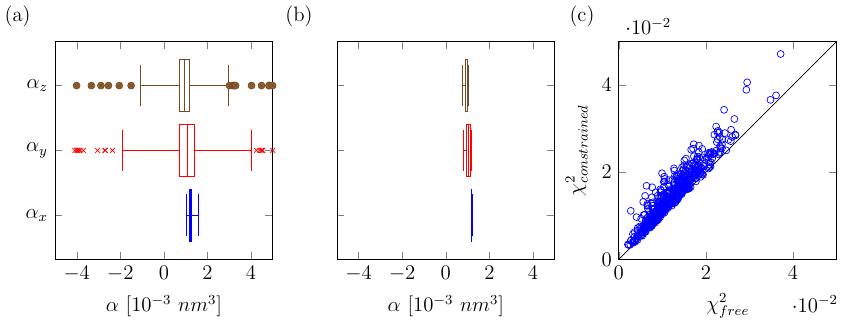
Figure 2: (a) Box plots of the calculated polarizabilities in either x, y or z dimension using the original fitting method per solvent configuration. (b) Box plots of the calculated polarizabilities in either x, y or z dimension using the new consensus fitting approach for polarizabilities. In panels (a) and (b), data are partitioned after sorting into four quartiles, and boxes depict the inter-quartile-range (irq) with a middle line that denotes the median. The whiskers are placed at the minimum and maximum values considered, with a maximum deviation of 4.0 times the irq. Outliers are denoted by circles (for α z ) and crosses (for α y ). (c) Error in fit ( χ 2 ) as obtained from the free unconstrained original fit (free) and compared to the constrained consensus-fit error in fit.